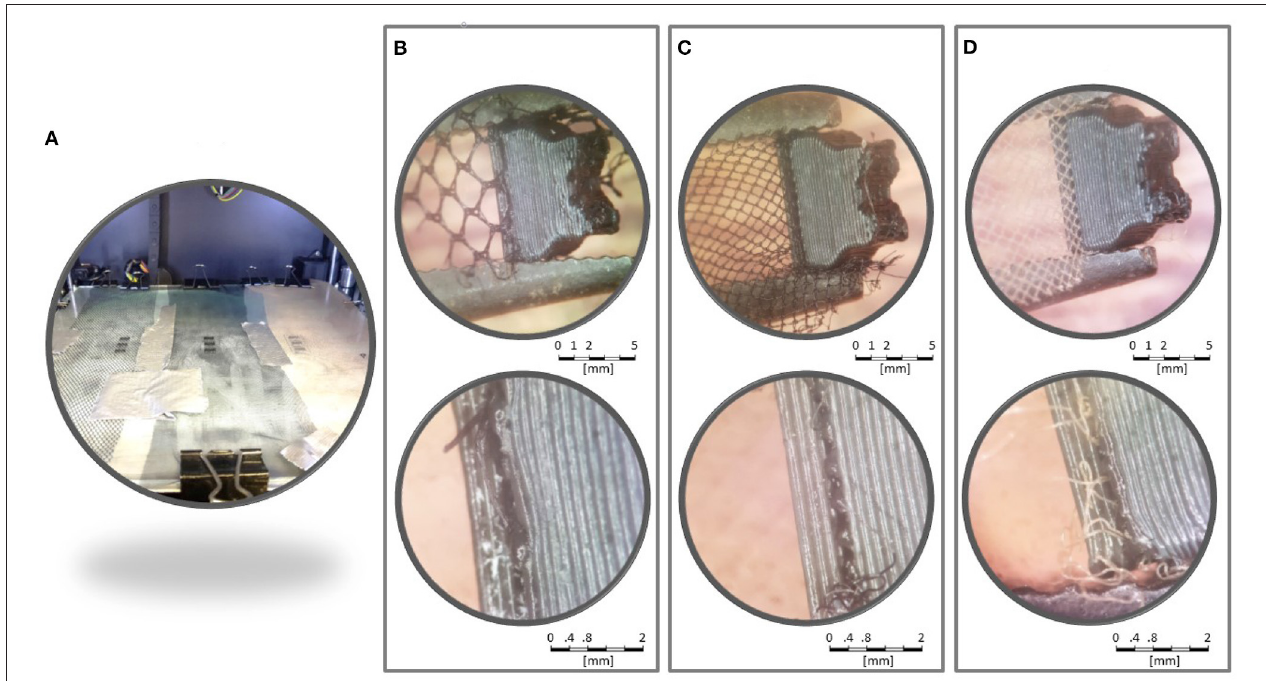
FIGURE 3 | Printing tests. (A) All three samples attached to the heated bed. Samples T3 (B) , T2 (C) , and T1 (D) were analyzed in a stereoscopic microscope.